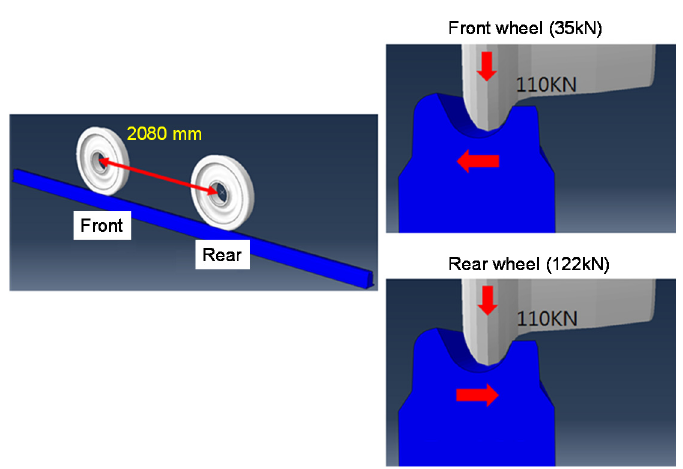
Figure 13. Analysis model of bogie wheels and stabilization track and load application.